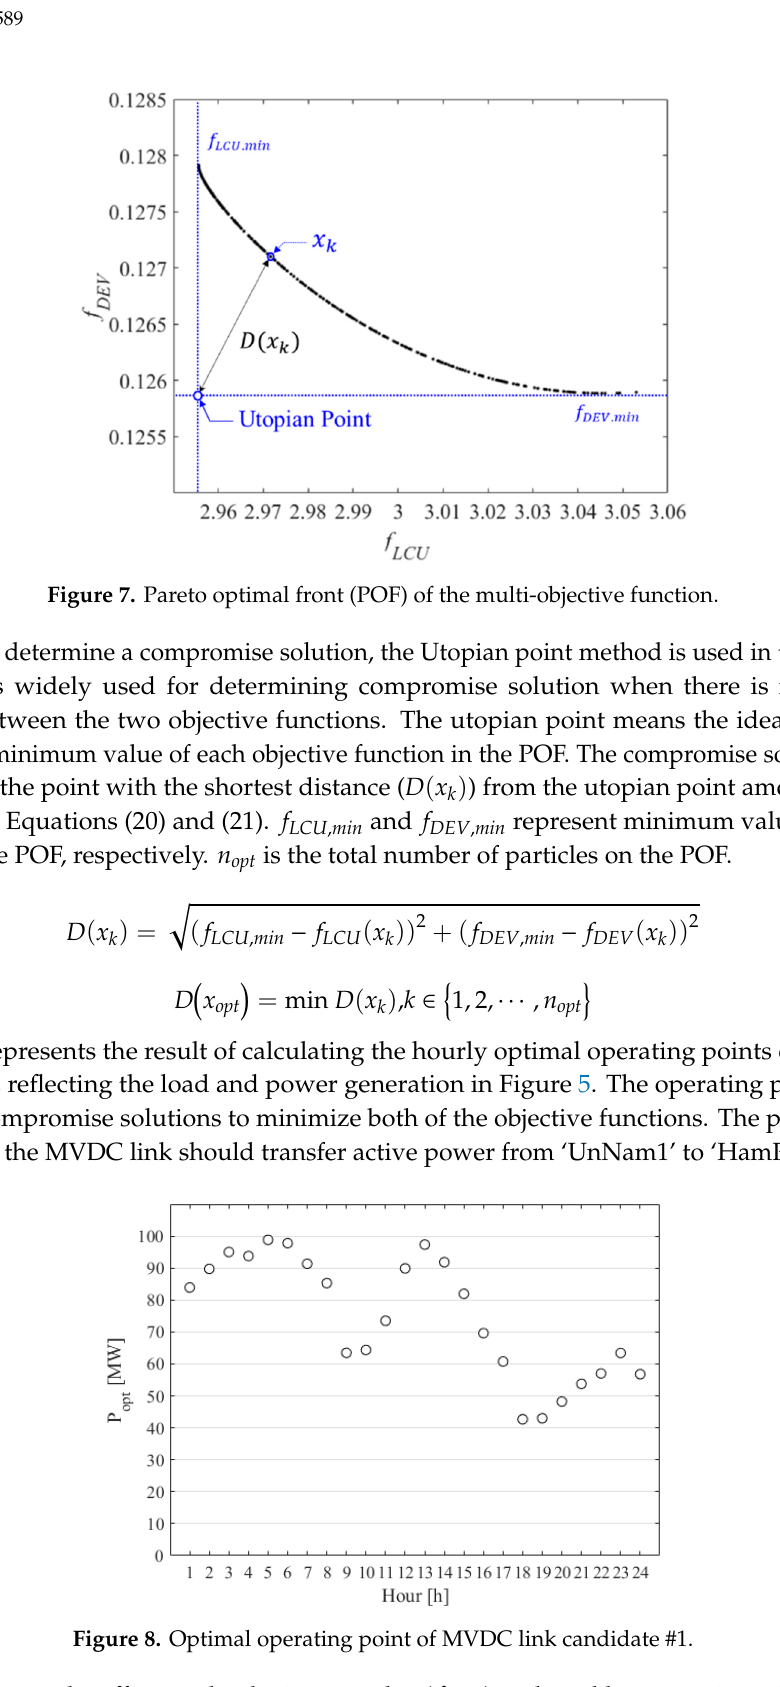
Figure 8. Optimal operating point of MVDC link candidate #1.